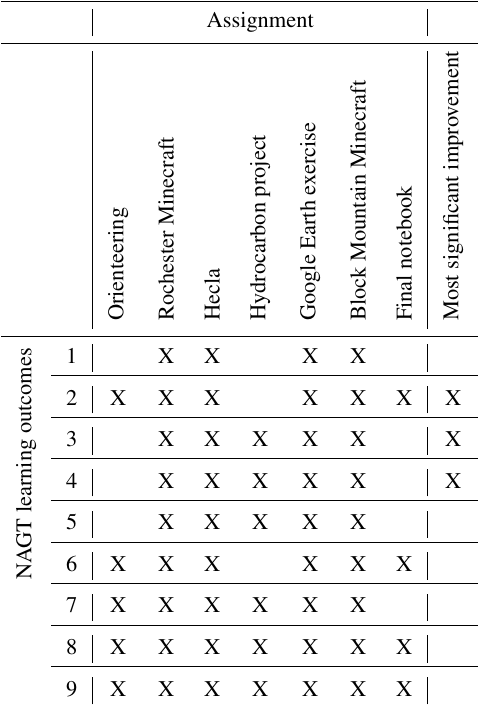
Table 3. NAGT learning outcomes where students showed the most improvement and the corresponding activities that targeted each